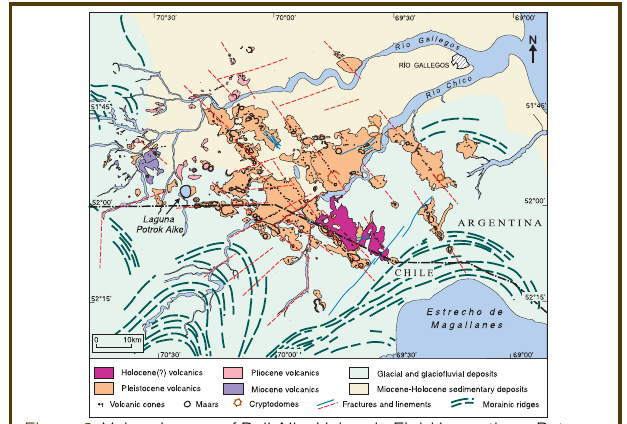
Figure 2. Volcanic map of Pali Aike Volcanic Field in southern Patago- nia (Argentina), showing radiometric ages of Pliocene to late Quater- nary volcanic back arc (modifi ed after Corbella,